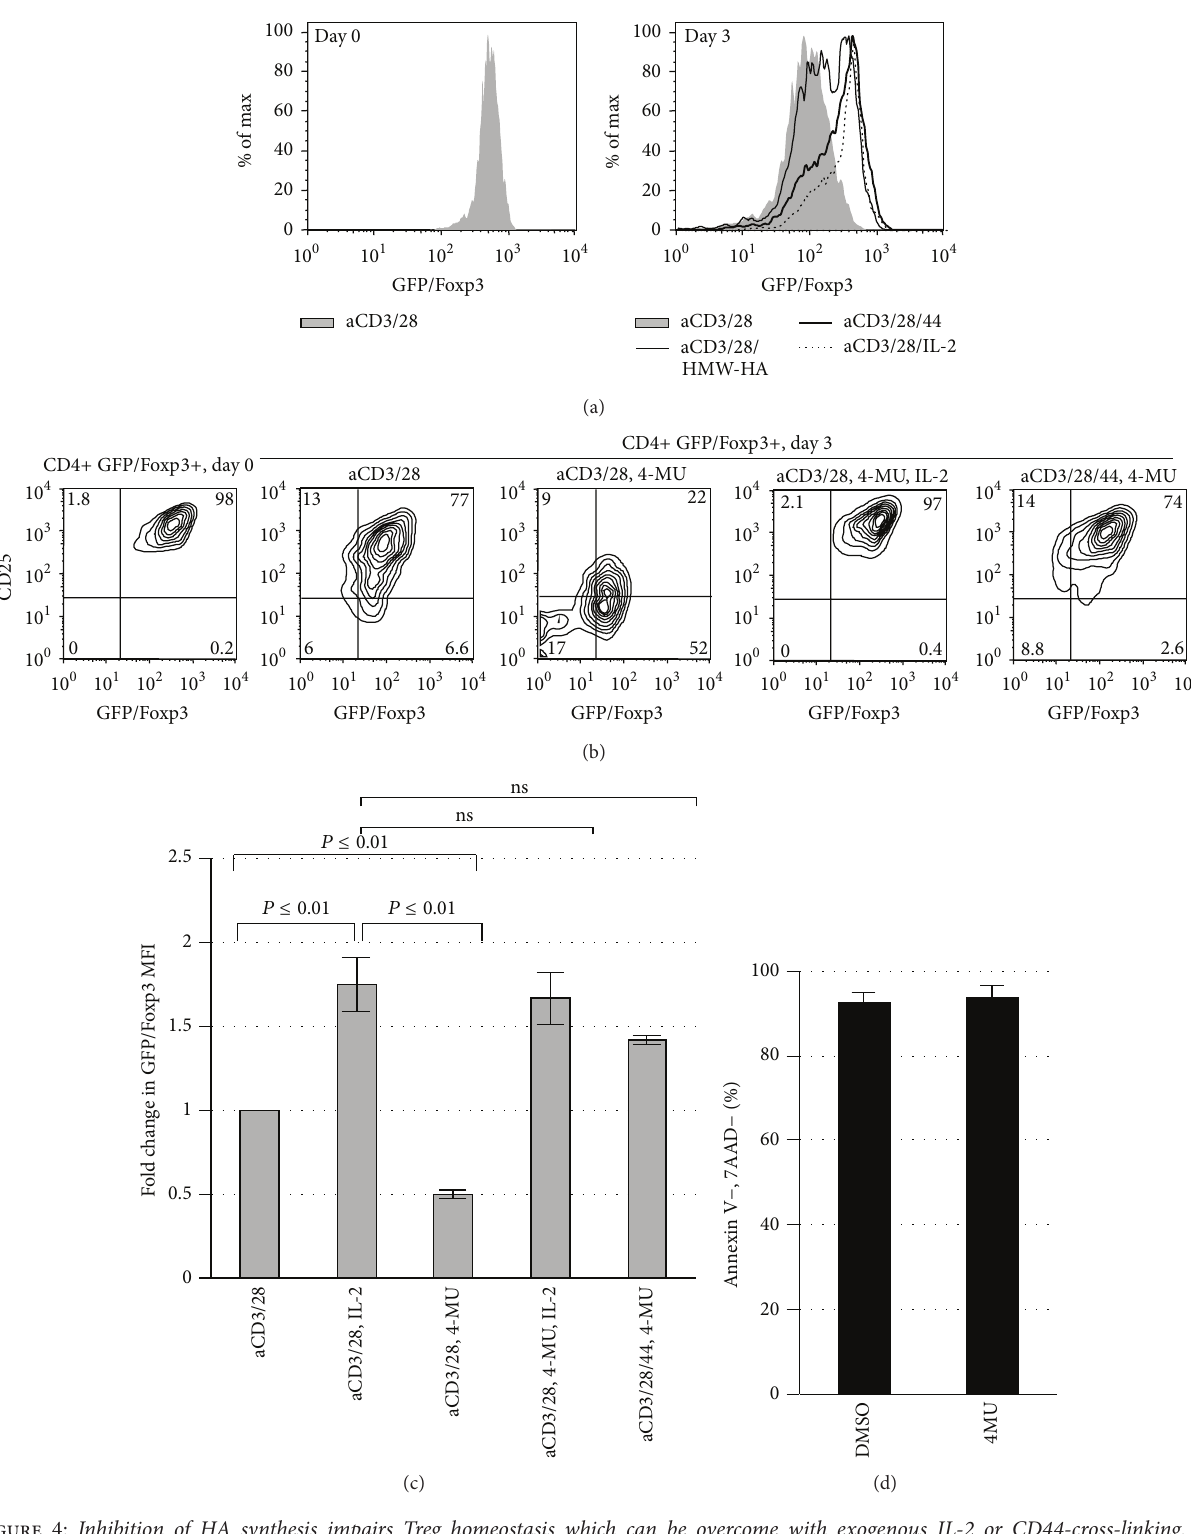
Figure 4: Inhibition of HA synthesis impairs Treg homeostasis which can be overcome with exogenous IL-2 or CD44-cross-linking . (a) Representative histograms of GFP/FoxP3 expression of Treg following 3 days of culture in the presence of anti-CD3 and anti-CD28 alone or with IL-2, CD44 cross-linking, or exogenous plate-bound HA. 𝑁 = 3 independent experiments. (b) Representative FACS plots illustrating GFP/Foxp3 and CD25 expression on Day 0 immediately following isolation of CD4+GFP/Foxp3+ Treg from murine splenocytes and following 3 days of culture with anti-CD3 and anti-CD28 Ab alone or in conjunction with plate-bound anti-CD44 Ab, the HA synthesis inhibitor 4-MU, and/or IL-2. (c) Fold change in GFP/Foxp3 MFI for the same conditions as in (b), here for 𝑁 = 3 independent experiments. (d) Viability (the percentage of GFP/Foxp3+ cells negative for 7AAD and Annexin V) for Treg cultured in the setting of either DMSO or